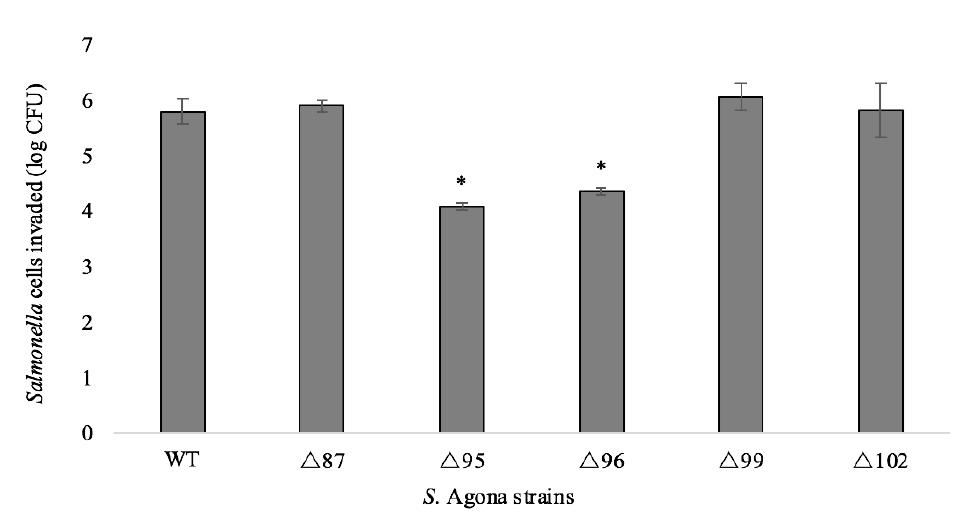
Figure 1. Caco-2 cell invasion capacity by the S. Agona strains. Error bars indicate the standard deviations of the means of three biological replicates. Means of the BIMs were compared to that of the WT. Asterisks located above mean values indicate significance below α = 0.05 (one-way ANOVA).